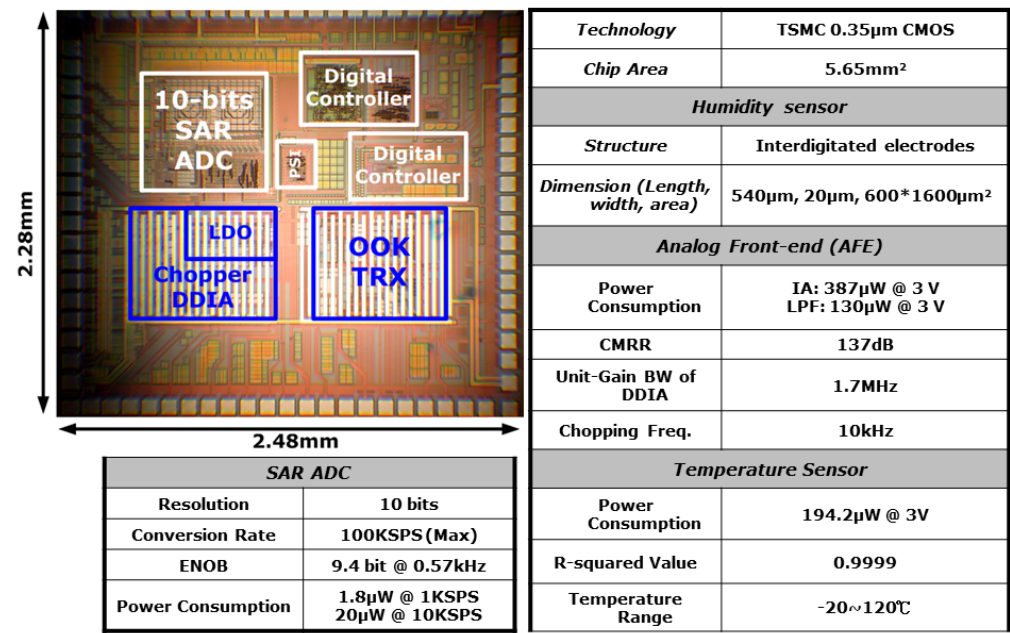
Figure 6. Chip photo and performance table of humidity sensing